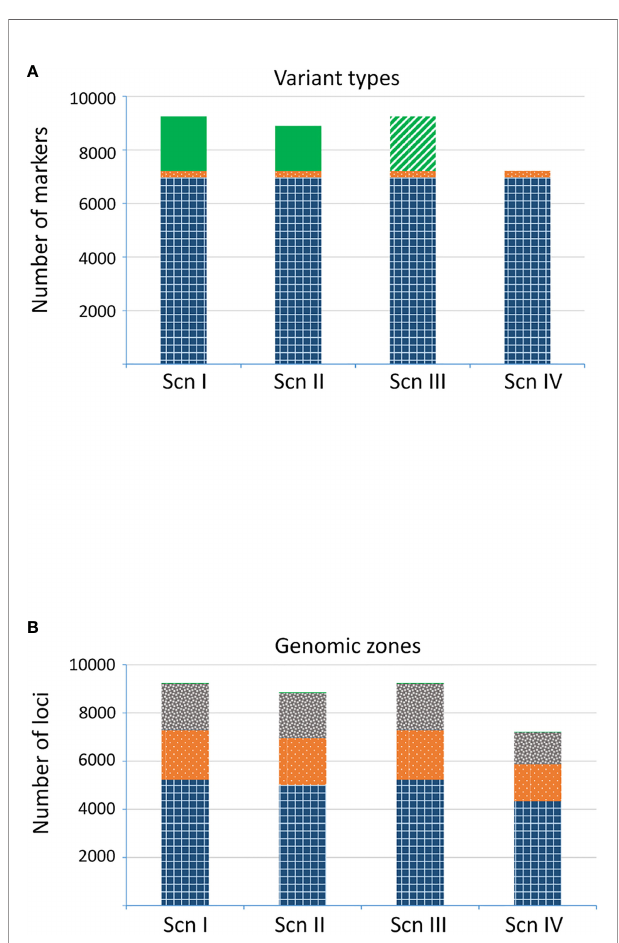
FIGURE 4 | Number of loci detected for each scenario. (A) Variant types: SNP (gridded blue), indel (dotted orange), and imputed loci (plain green; treated as missing data in ScnIII). (B) Genomic region: known exonic region (gridded blue), known intronic region (dotted orange), intergenic region (grey confetti), not assigned region (plain